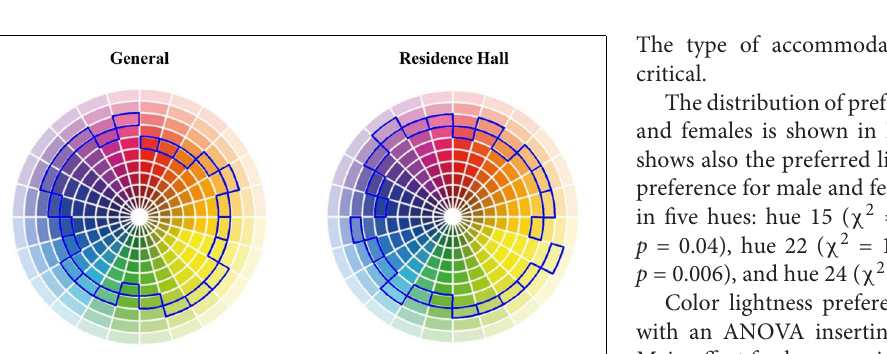
FIGURE 6 | General chromatic preference (%) in females (left bar) and males (right bar) for the 24 hues shown in Figure 4 . Lightness level of each bar matches the mean preferred lightness level (radial axis in Figure 4 ). Asterisks show the significance level for the male-female comparison ( ∗∗ p < 0.01, ∗∗∗ p < 0.001).